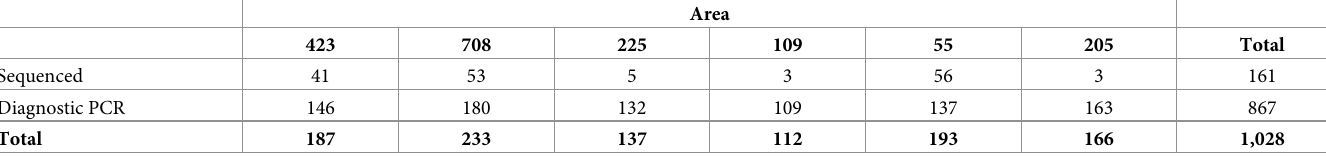
Table 2. Number of genotyped mosquitoes from each area.